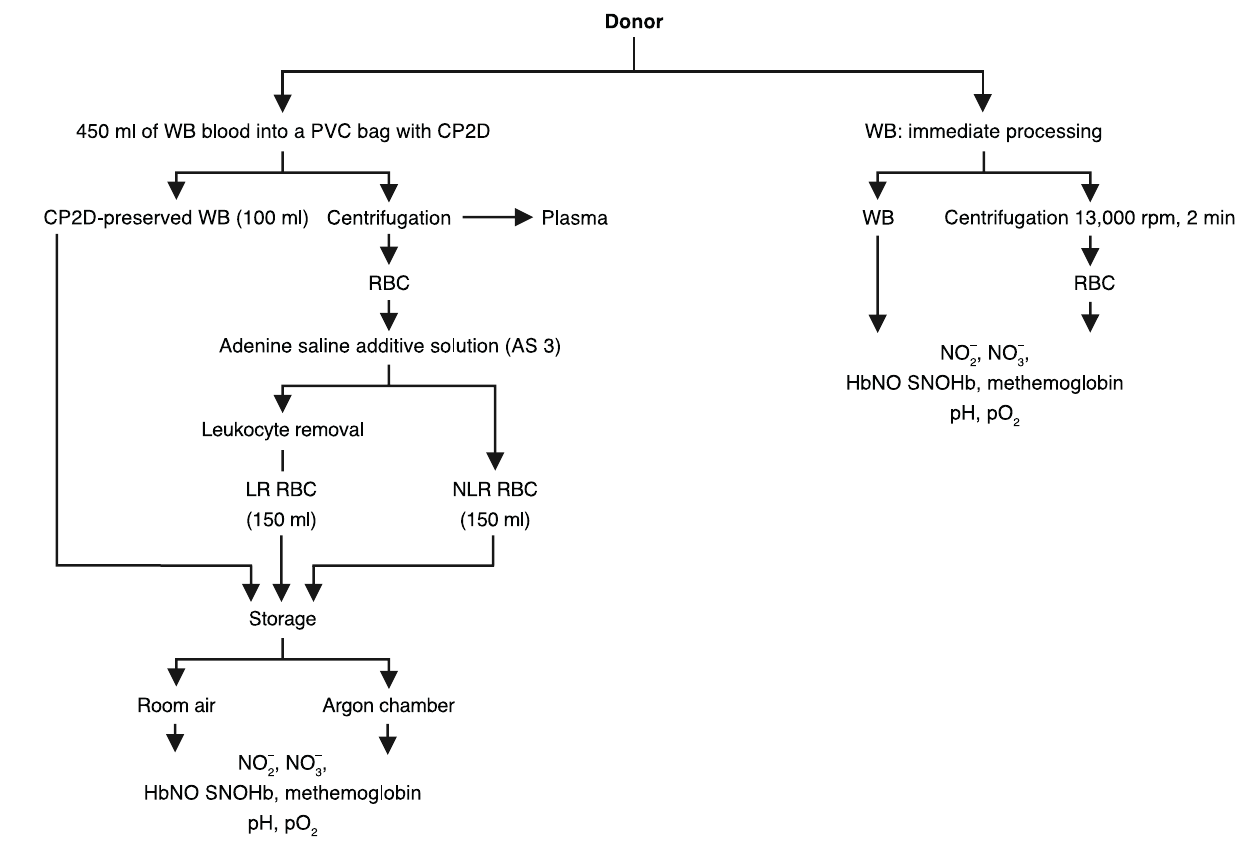
Supplemental Figure 1. Outline of study